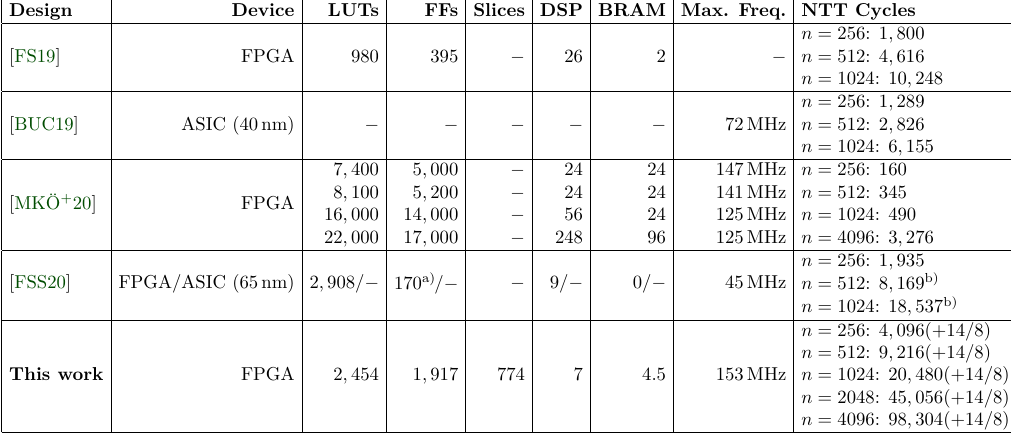
Table 2: Resource and performance overview for loosely coupled NTT (measurements of this work evaluated for Artix 7 FPGA